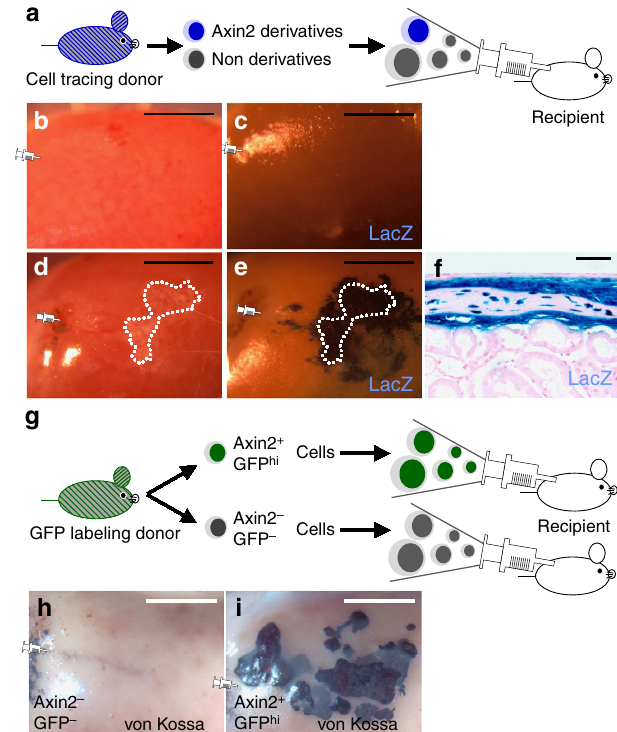
Figure 5 | Skeletal stem cells residing in the suture mesenchyme are enriched in the Axin2-expressing cell population. Diagrams illustrate our strategies to examine whether the regenerated bone originates from the Axin2-expressing cells ( a ) and to determine their regenerative potential ( g ) using the cell tracing and GFP labelling models, respectively. Transplantation with inclusion of no cell ( b , c ), or suture mesenchymal cells ( d – f ) isolated from the Axin2 Cre-Dox ; R26RlacZ mice, examines contribution of the Axin2-expressing cells and their derivatives, stained positive for b -gal, to the ectopic bone formation. Regeneration analysis is performed on the Axin2 (cid:2) ( h ) and Axin2 þ ( i ) cell populations, isolated from the Axin2 GFP calvaria, after their separation based on the differential expression of GFP. staining in whole mount ( c , e ) and sections ( f ) and von Kossa staining ( h , i